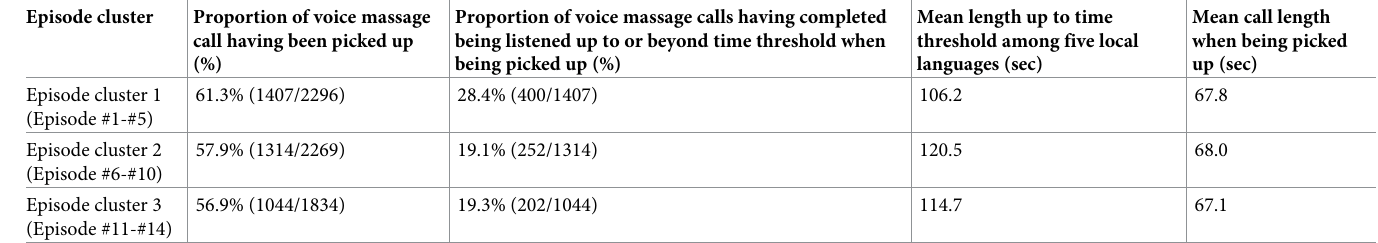
Table 4. Participants’ adherence to voice messages.